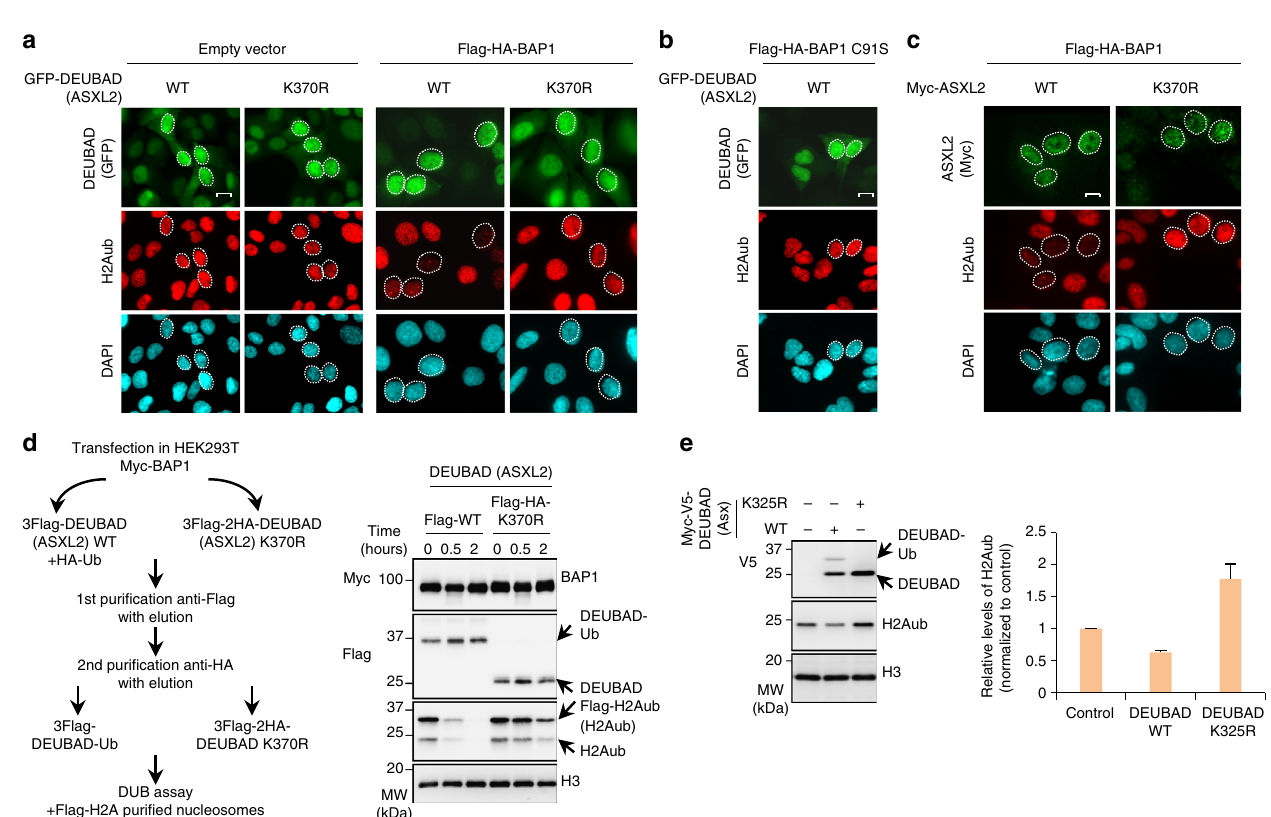
Fig. 7 Monoubiquitination of DEUBAD K370 promotes BAP1 DUB activity. a Expression of DEUBAD (ASXL2) but not DEUBAD (ASXL2) K370R, results in reduced levels of H2Aub in BAP1-dependent manner. U-2 OS cells stably expressing empty vector or Flag-HA-BAP1 were transduced with lentiviral expressing vectors for either GFP-DEUBAD (ASXL2) or GFP-DEUBAD2 (ASXL2) K370R and endogenous level of H2Aub was analyzed by immuno fl uorescence. GFP DEUBAD (ASXL2) (green), H2Aub (red), DAPI (blue). n = 3 biological replicates. b DEUBAD induces reduction of H2Aub levels in BAP1 catalytic activity dependent manner. U-2 OS cells stably expressing Flag-HA-BAP1 C91S were infected with either GFP-DEUBAD (ASXL2) or GFP-DEUBAD (ASXL2) K370R and H2Aub levels were assessed (see also Supplementary Fig. 7). n = 2 biological replicates. c Expression of ASXL2, but not ASXL2 K370R, results in reduced levels of H2Aub. U-2 OS cells stably expressing Flag-HA-BAP1 were infected with lentiviral expressing vectors for either Myc-ASXL2 or Myc-ASXL2 K370R and H2Aub changes were evaluated by immunostaining. n = 2 biological replicates. The cells showing either decrease or no change of H2Aub levels were encircled in panels a – c . Scale bar: 10 μ m for panels a – c . d Monoubiquitinated form of DEUBAD (ASXL2) strongly promotes BAP1 DUB activity comparatively to DEUBAD (ASXL2) K370R. Puri fi ed BAP1/DEUBAD complexes from HEK293T cells were used for in vitro DUB assays with Flag-H2A nucleosomes and analyzed by immunoblotting. n = 2 biological replicates. e Monoubiquitinated DEUBAD promotes deubiquitination of H2Aub in Drosophila . S2 cells were transfected with either Myc-V5-DEUBAD (Asx) or Myc-V5-DEUBAD (Asx) K325R and harvested for immunoblotting. Right panel, densitometry analysis of the levels of H2Aub is shown. Error bars represent s.d. (mean ± SD). n = 3 biological replicates. Histone H3 was used as a loading control for panels d and e